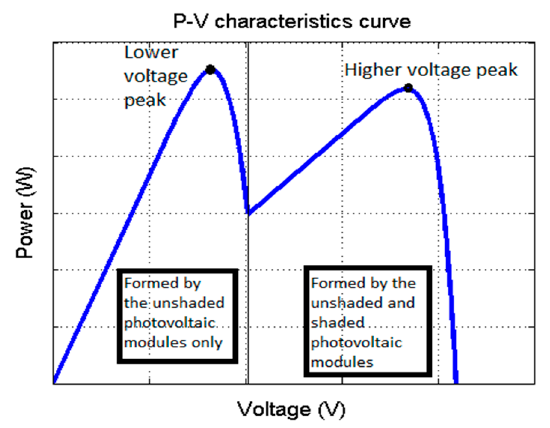
Figure 20. Higher and lower voltage peak of the P-V characteristics.